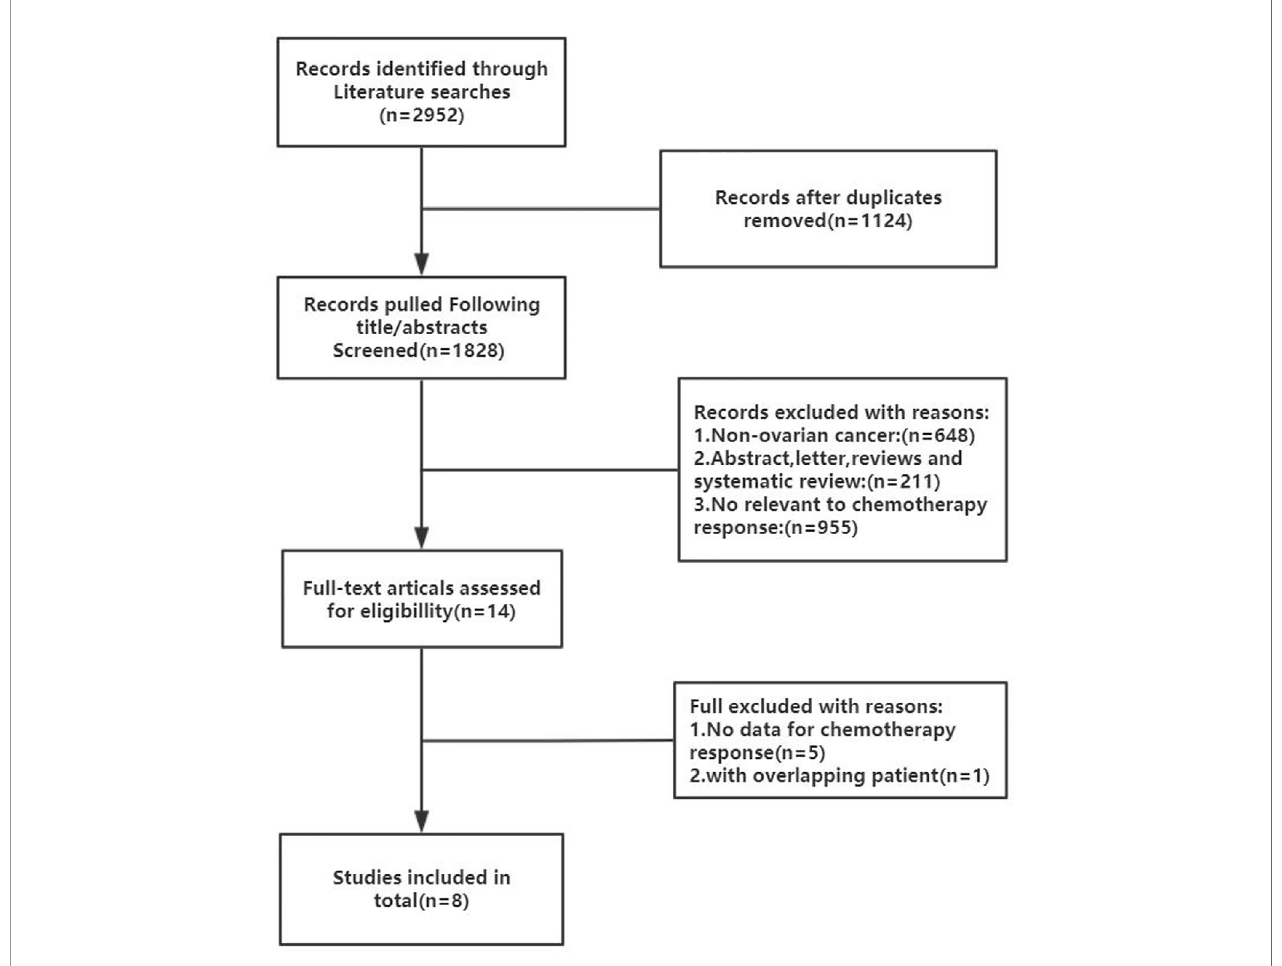
FIGURE 1 | Flow chart of the literature search and selection process in the MEDLINE (PubMed), EMBASE, Cochrane Central, Web of Science, SCOPUS, and